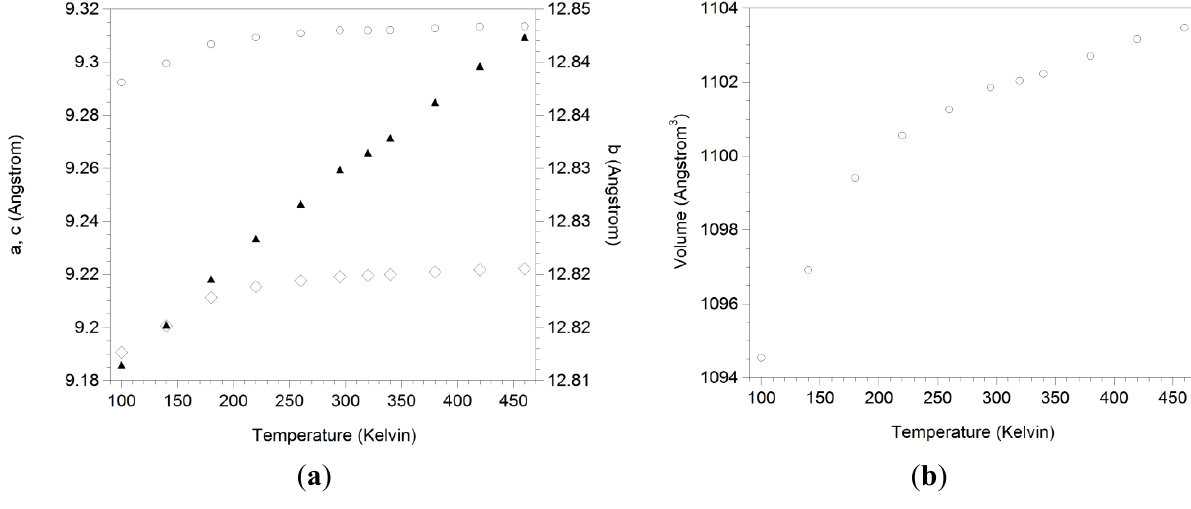
Figure 6. Expansion data of ( a ) unit cell axes a (  ), b (  ) and c (  ); and ( b ) unit cell volume of AlScMo 3 O 12